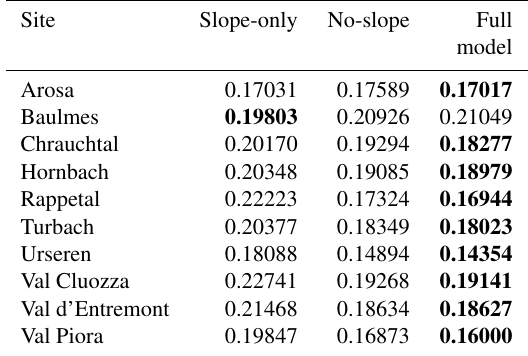
Table 4. Brier scores for the slope-only model compared with Brier scores of the no-slope and full models for all sites. The values dis- played are median values of the bootstrapped Brier scores (500 rep- etitions). Lower scores are better (bold font) than higher